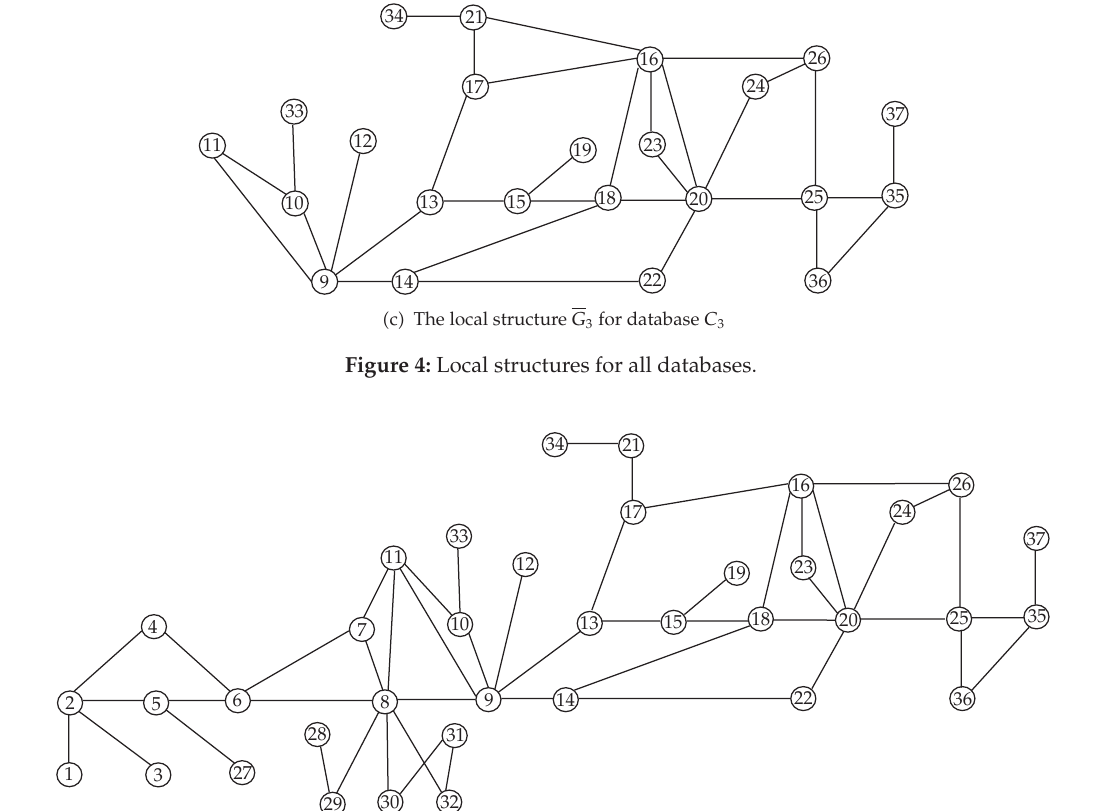
Figure 5: The global undirected